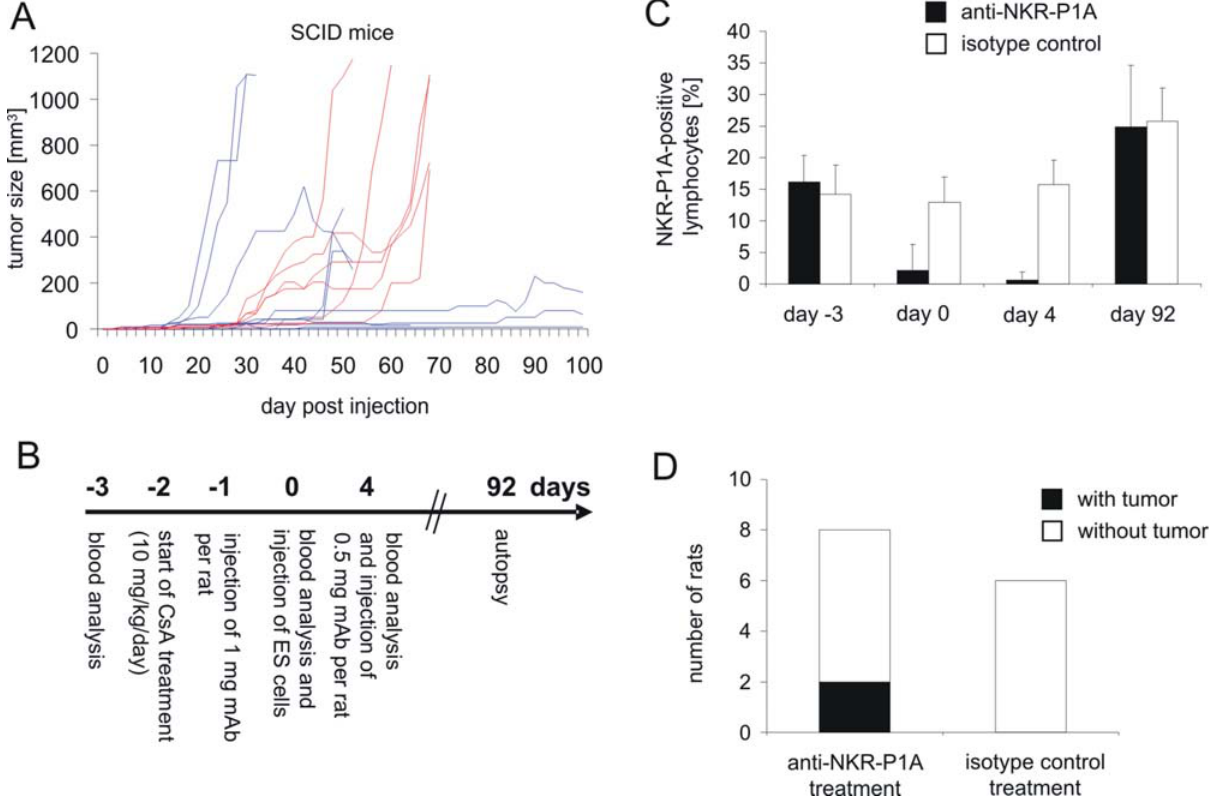
Figure 8. Analysis of effects of NK cells on the rejection of ES cells in vivo. (A) 1 6 10 6 ES cells were injected subcutaneously at day 0 into 15 T and B cell deficient SCID mice which have functional NK cells. The tumor size was recorded every second day until day 100 using linear calipers. The growth of tumors in individual mice is shown. Tumor growth in female hosts is indicated by red lines and in male hosts by blue lines. In one animal a tumor regression was observed. (B) The treatment scheme of rats receiving an NK cells depleting antibody (anti-NKR-P1A) or an isotype control is shown. (C) The mean proportion plus SD of NK cells in the blood of male LOU rats receiving the anti-NKR-P1A mAb (n=8) or the isotype control (n=6) is shown. Blood cells were stained with the respective mAb and analyzed by flow cytometry after lysis of erythrocytes. (D) The proportion of the male rats in which tumors were found at autopsy is indicated. The size of the tumors was 12 mm 3 and 16 mm 3 , respectively. Both were palpable for more than 30 days before